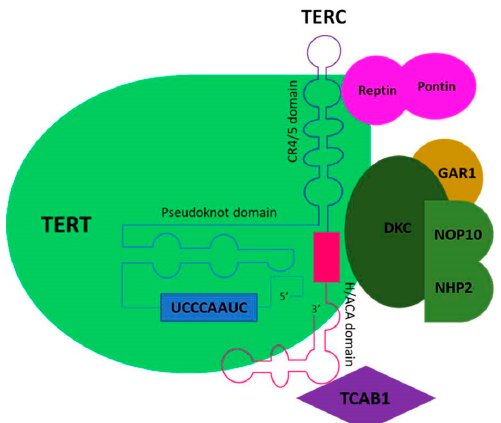
Figure 2. Telomere elongation relies on telomerase, a ribonucleoprotein including a catalytic subunit telomerase reverse transcriptase (TERT) and an RNA component (TERC). Telomerase extends telomeres by adding hexameric 5 ′ -TTAGGG-3 ′ tandem repeats to the chromosomal ends via reverse transcription using an intrinsic RNA template region (UCCCAAUC). TERT protein comprises anchor sites for telomeric DNA and also contributes to telomere catalysis. TERC component contains three conserved domains: the template/pseudoknot domain, the CR4/5 domain that are required for telomerase activity and the H/ACA domain, conserved in all vertebrates. Maturation of telomerase involves an elaborate number of molecules, among which TCAB1 that recruits mature telomerase complex. Furthermore, in vivo telomerase function needs auxiliary protein components, including DKC, NOP10, GAR1, NHP2, reptin and